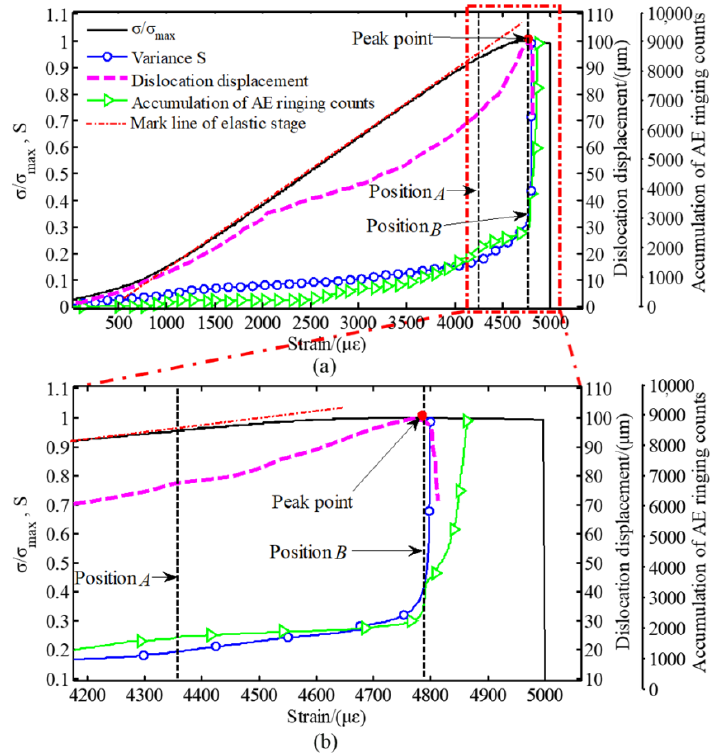
Figure 4. Curves for different parameters: ( a ) Whole process loading; ( b ) non-linear stage.